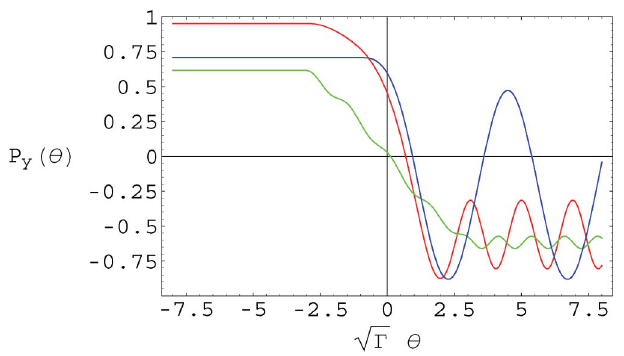
FIG. 5. (Color) Single-particle polarization as function of time during a sloped-step resonance crossing for three example